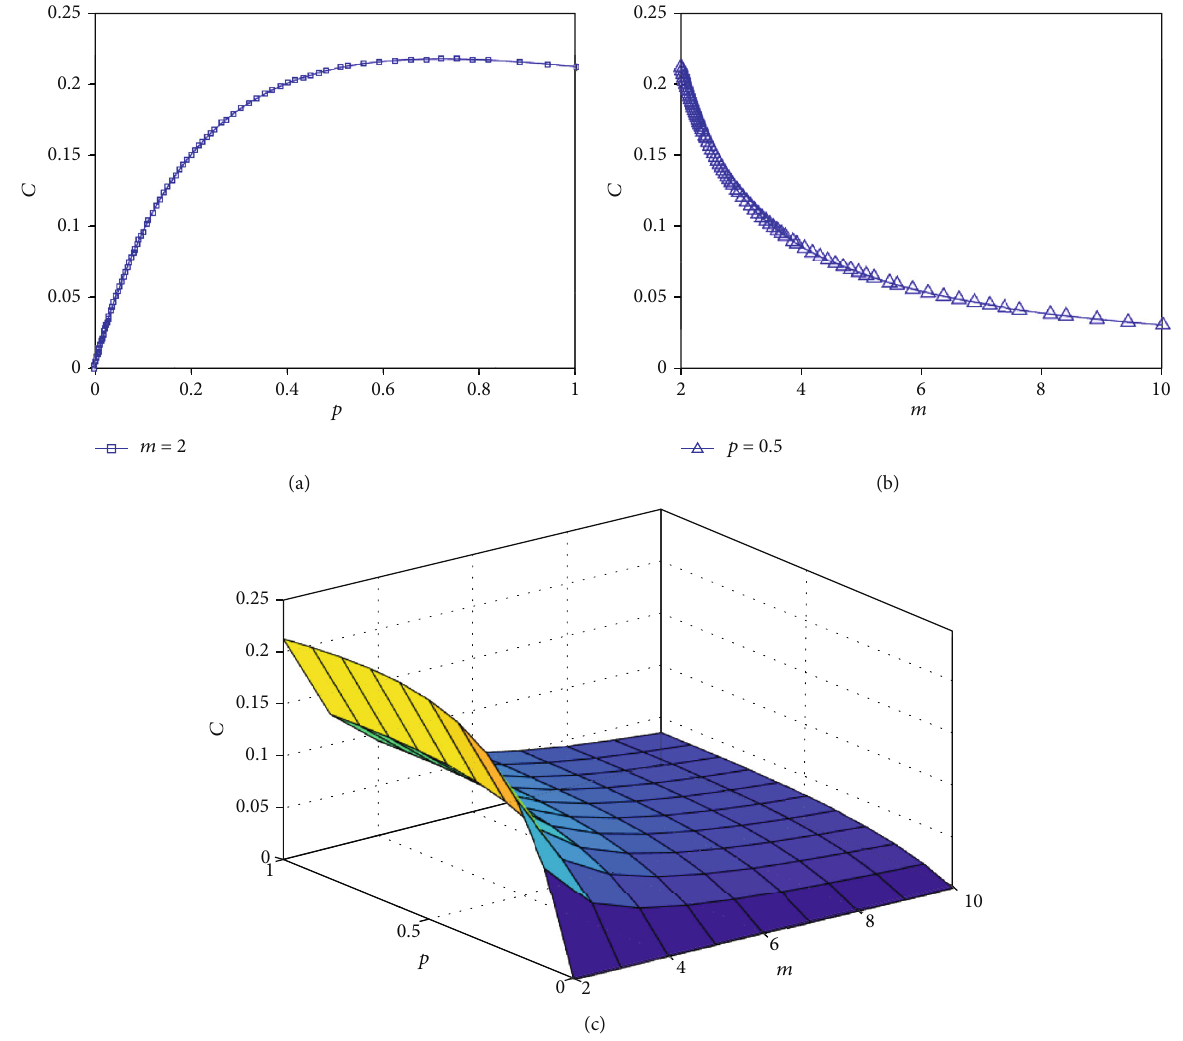
Figure 6: Stable clustering coe ffi cient of the